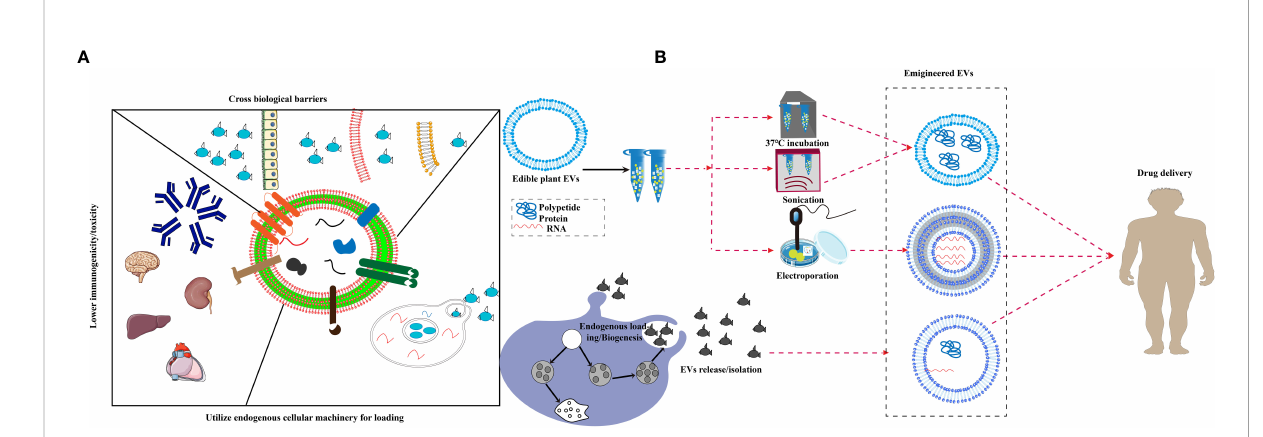
FIGURE 2 Bioactives delivery methods for edible plant-derived EVs. (A) Proposed unique features of extracellular vesicles, EVs are believed to be able to cross various biological barriers and deliver cargo across endosomal membranes, and display lower toxicity in spleen, brain and liver as well as reduced immunogenicity. (B) A schematic diagram displaying the strategy for endogenous loading of engineered EVs, EVs package exogenous substances through ultrasound, co-incubation, electroporation and chemical modi fi cation, then pass various biological